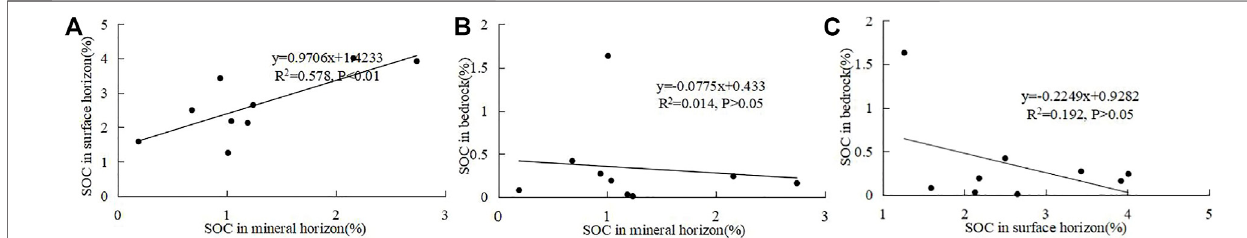
FIGURE 3 | Correlations between SOC in the surface horizon and the mineral horizon (A) , mineral horizon and bedrock (B) , and surface horizon and bedrock (C) .